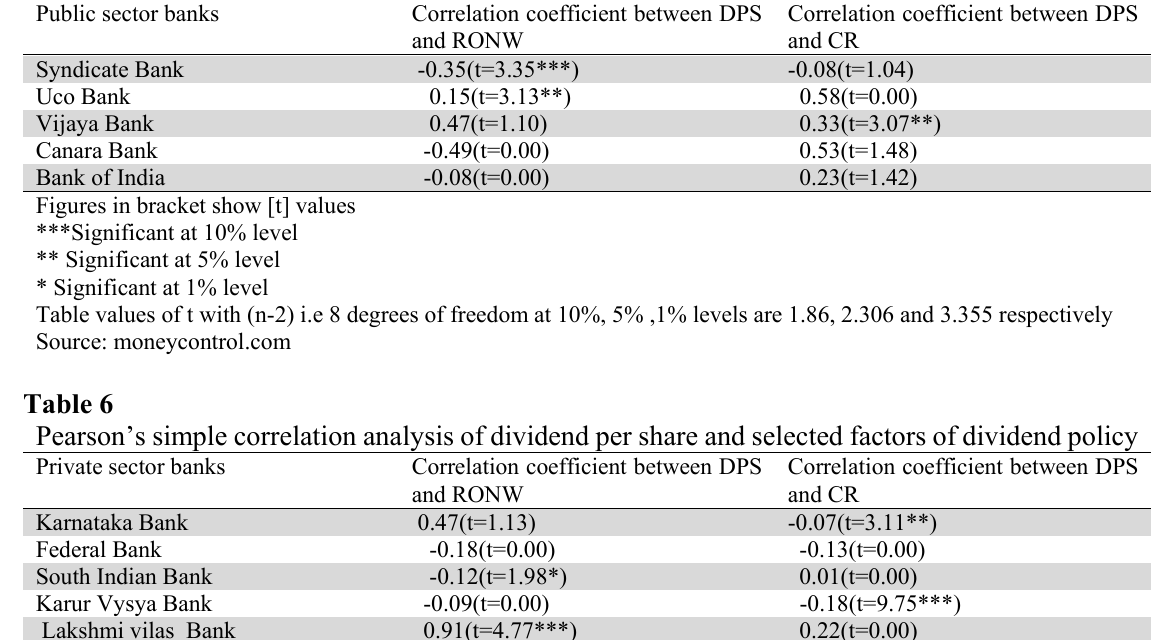
Figures in bracket show [t] values